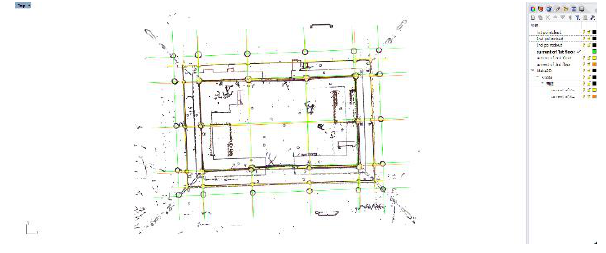
Figure 15. result after